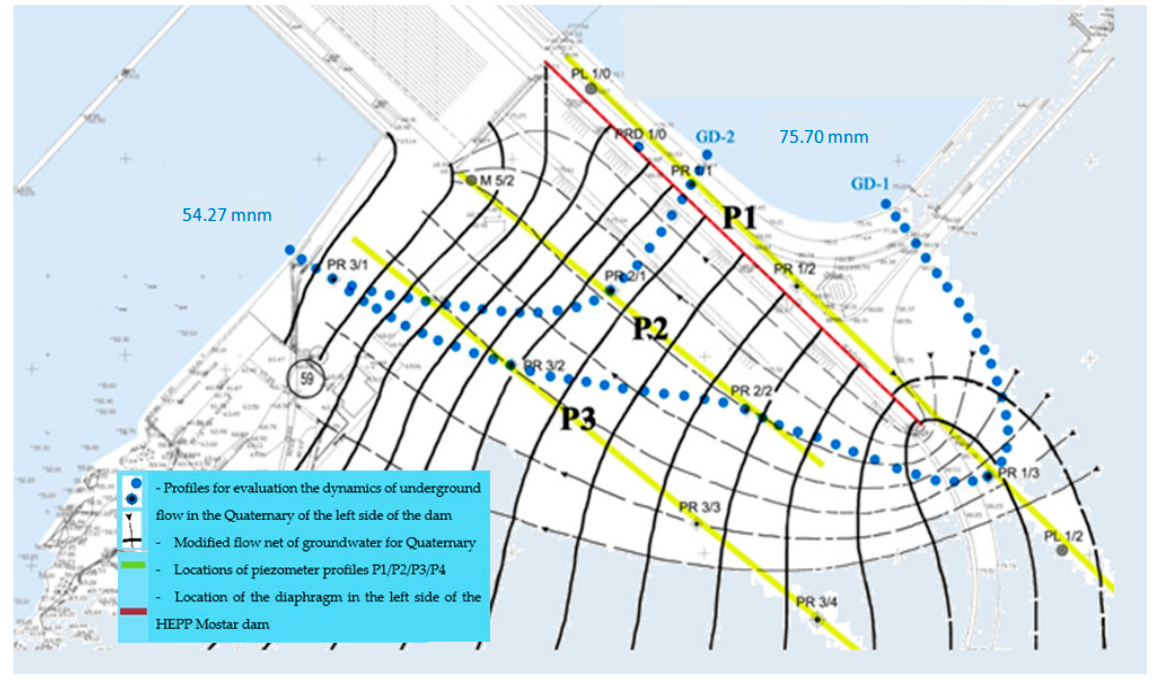
Figure 10. Modification of streamlines around the diaphragm